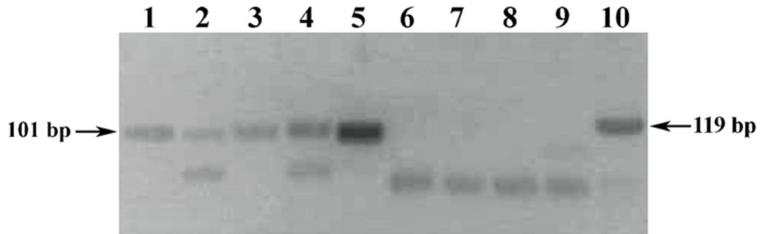
Figure 3. Electrophoregram of the results of PCR amplification of the Vitis vinifera L. UFGT gene locus. Legend: (1–4) PCR samples of DNA amplified with UFGT-F and UFGT-R primers, extracted from precipitated wine debris: (1–2) a 3-day exposure of wine material with isopropanol: (1) Chardonnay;